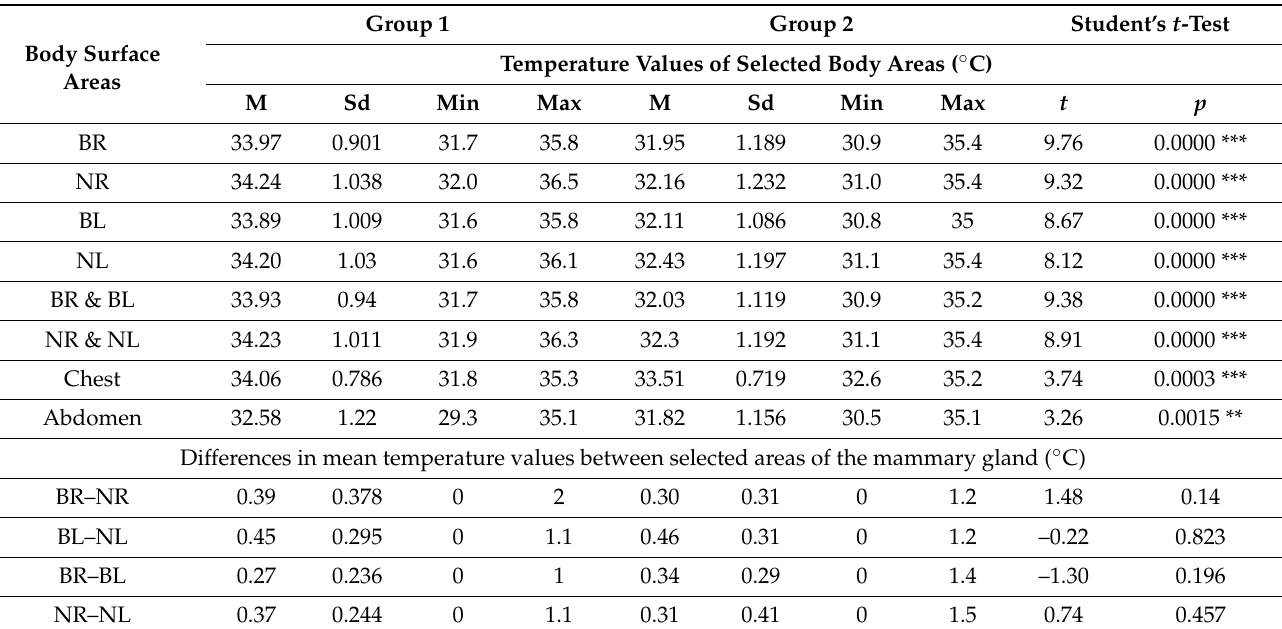
Table 2. Descriptive statistics of the temperature values (T mean ) of the selected body surface areas and the results of the significance tests of differences between the studied groups of women.